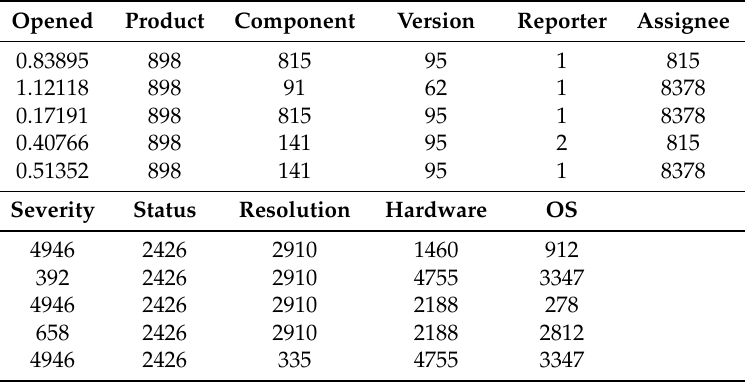
Table 2. A part of the numerical value converted from the raw fault big